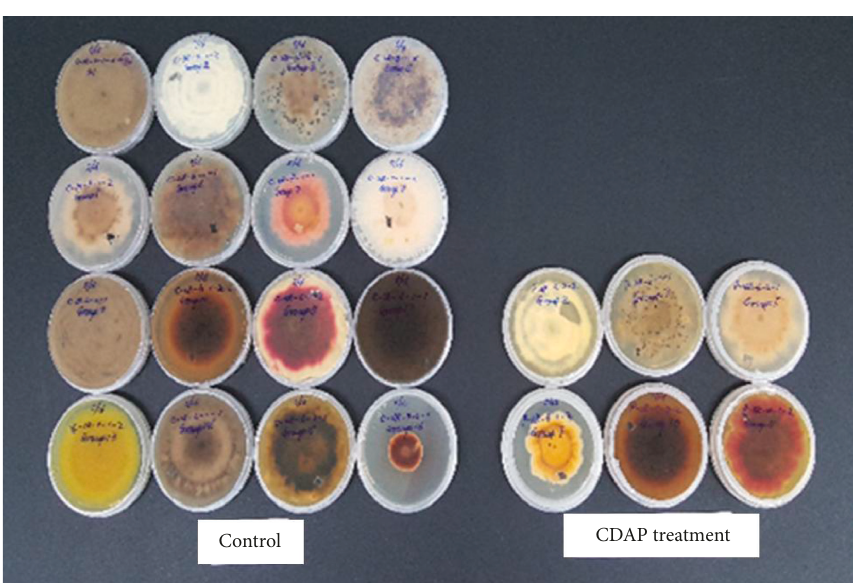
Figure 3: Colors of representative fungal isolates grown on potato dextrose agar isolated from nontreated or CDAP-treated onions.